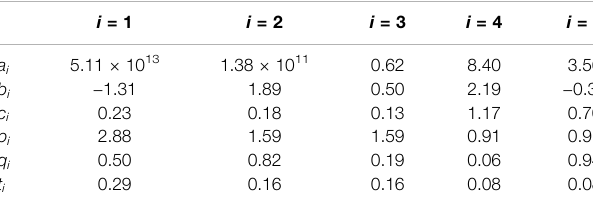
TABLE 1 | Coef fi cients of the fi tting function versus phase